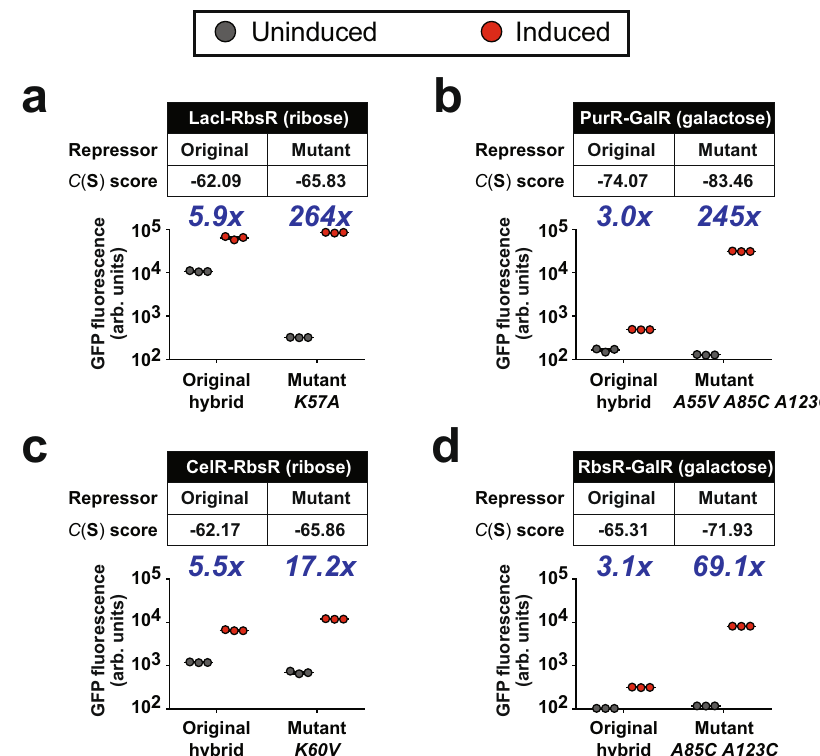
Fig. 2 Experimental characterization of modi fi ed hybrid repressors with signi fi cant improved performance. We assessed the ability of hybrid repressors in gene expression regulation and allosteric response, by using a transcriptional reporter assay in a strain of E. coli with GFP as a reporter of transcription activities. Four hybrid repressors were improved, including ( a ) LacI-RbsR, ( b ) PurR-GalR, ( c ) CelR-RbsR, and ( d ) RbsR-GalR. As shown in the table in each panel, our compatibility model predicts that each mutant gains improved performance, based on the compatibility scores C ( S ). Indeed, these mutants showed increases in a dynamic range of gene expression in response to their inducers. GFP fl uorescence in cells measured from three biological replicates are illustrated with markers that are gray (uninduced) and red (induced). The inducer used is shown inside a bracket in each table. The blue number above each plot represents the corresponding fold-change of GFP induction. The mean ± S.D. of the three biological replicates is also shown in each plot. Source data are provided as a Source Data fi